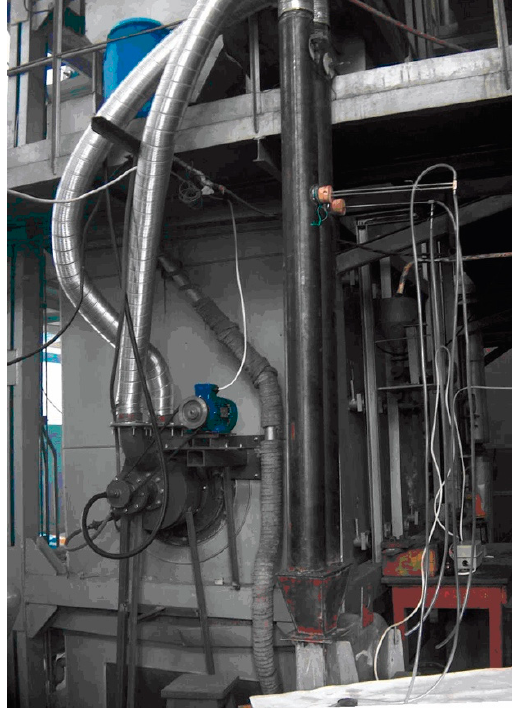
Figure 6. Experimental installation.